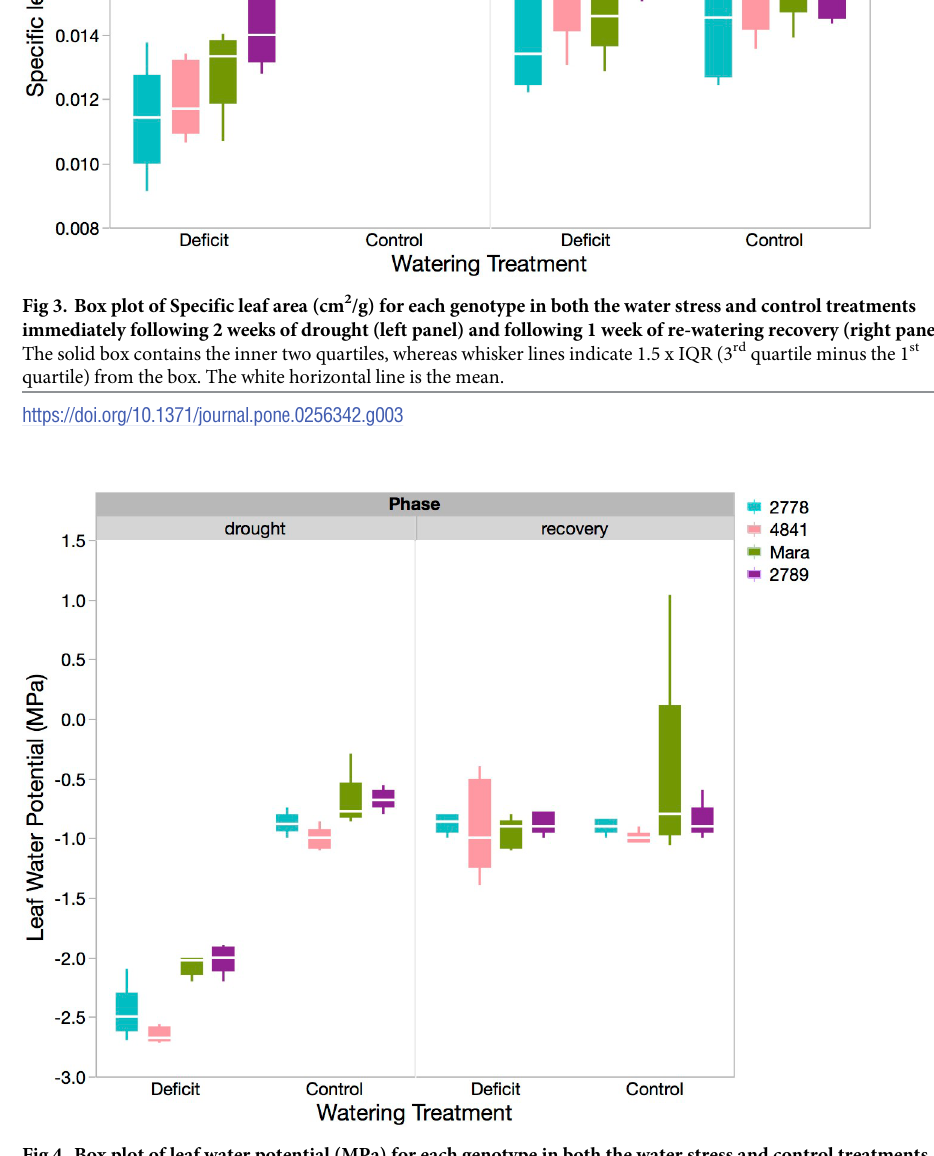
Fig 4. Box plot of leaf water potential (MPa) for each genotype in both the water stress and control treatments after re-watering recovery (right panel). The solid box contains the inner two quartiles, whereas whisker lines indicate 1.5 x IQR (3 rd quartile minus the 1 st quartile) from the box. The white horizontal line is the mean.